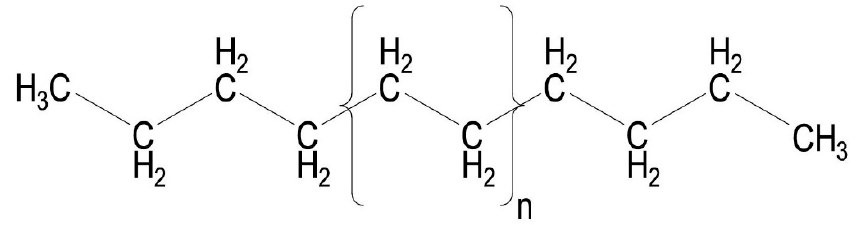
Figure 5. Structural formula of pure polyethylene.